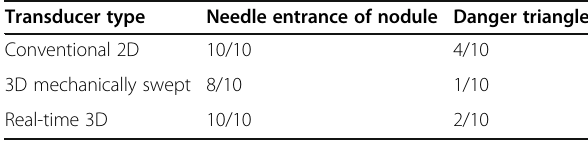
Table 3 Number of observed ablated locations outside the